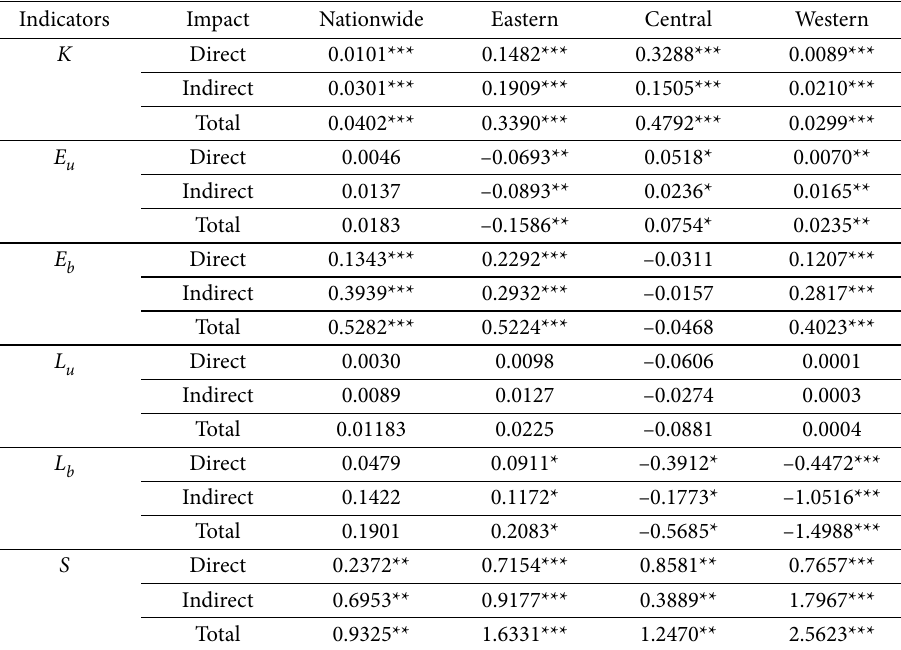
Table 5. Regional cumulative effect analysis of educational